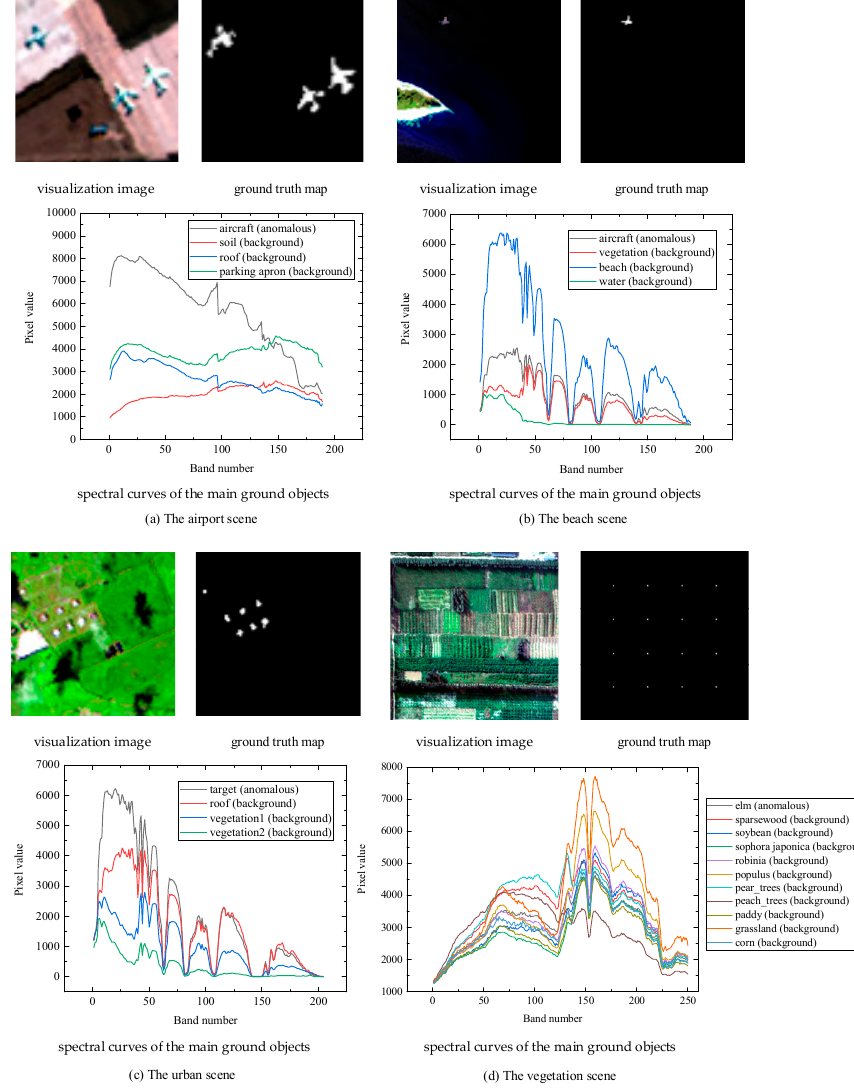
Figure 3. The visualization image, its ground truth map, and the spectral curves of the main ground objects in ( a ) the airport scene, ( b ) the beach scene, ( c ) the urban scene, and ( d ) the vegetation scene.